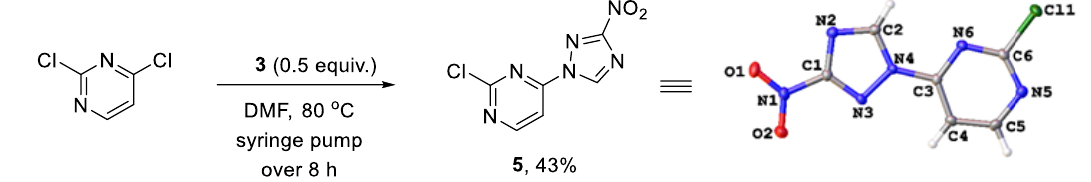
Scheme 2. Synthesis of 2-chloro-4-(3-nitro-1 H -1,2,4-triazol-1-yl)pyrimidine ( 5 ) and its single-crystal